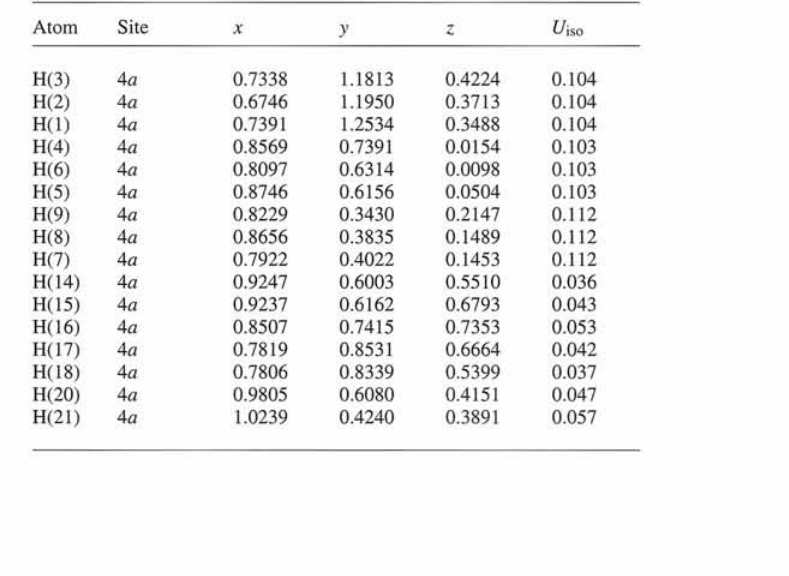
Table 2. Atomic coordinates and displacement parameters (in Â 2